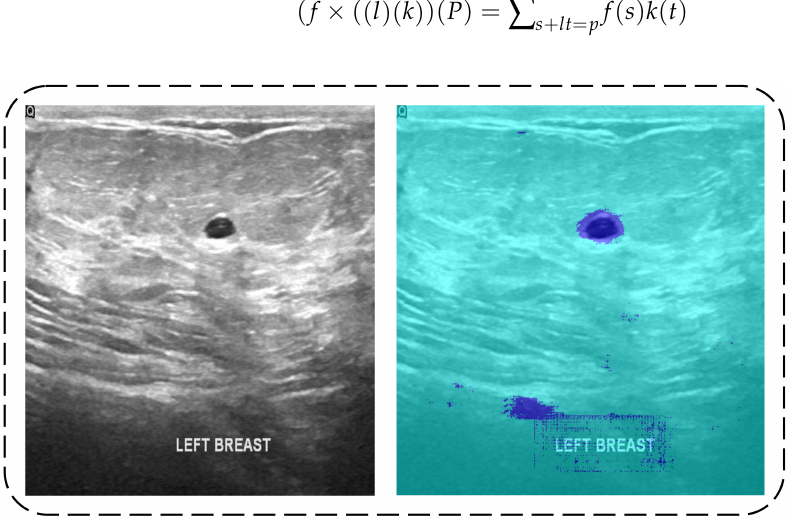
Figure 3. Original Image ( left ) and Di-CNN Prediction ( right